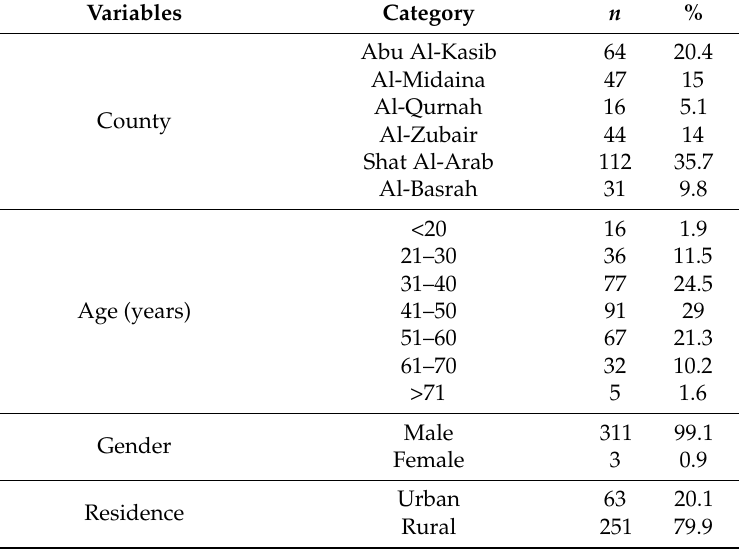
Table 1. Socio-demographic characteristics of livestock farmers (N = 314) participated in cystic echinococcosis (CE) knowledge, awareness and practices survey in Basrah,